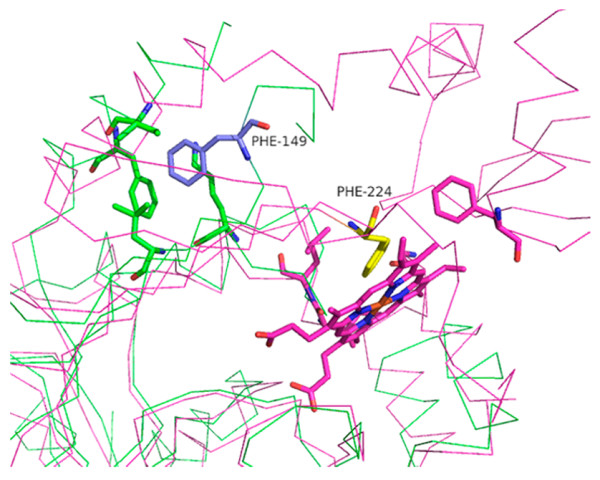
 Conformational comparison between Phe149of HutZ and thecorresponding residue Phe224of HugZ. HutZ is displayed in green ribbon and HugZ in magenta ribbon. Phe149 is labeled as blue stick, and its side chain points to hydrophobic pocket formed by residues in green. Phe224 is in yellow stick, and its side chain points in opposite direction.